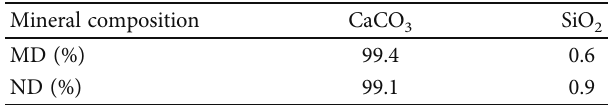
Table 4: Volume fraction of mineral composition in MD and ND. Mineral